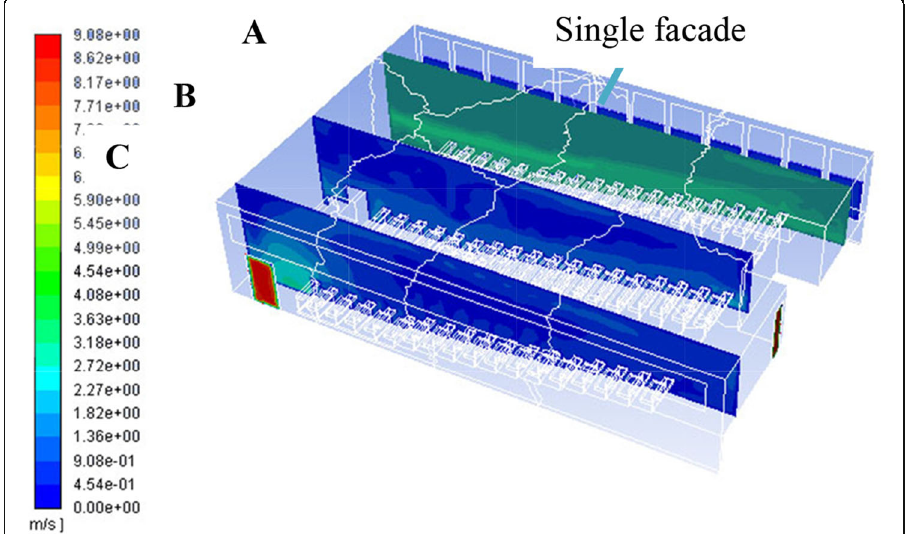
Fig. 3 The air velocity at the windows captured from the CFD model (source: the